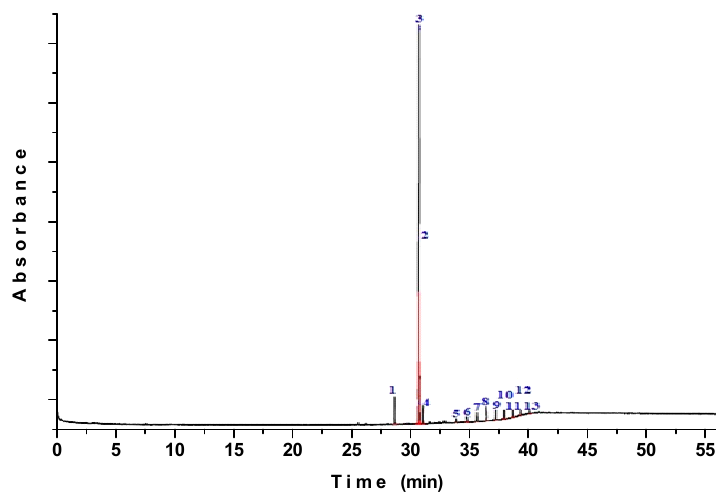
Figure 1. GC–MS chromatograms of sacha inchi oil before the simulated gastrointestinal digestion.